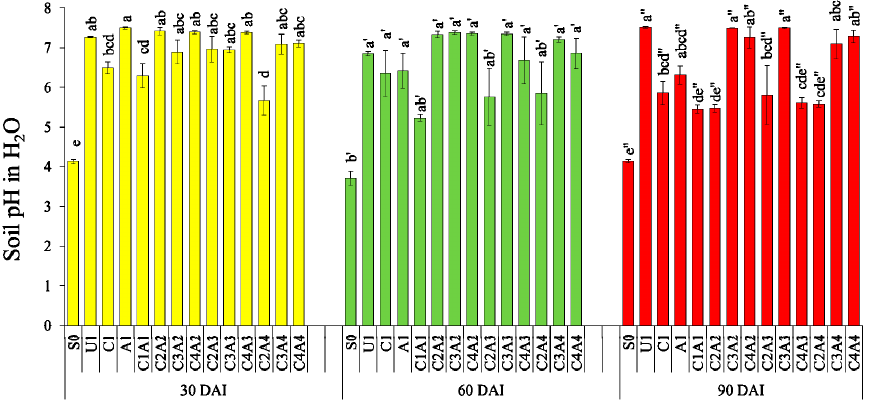
Figure 2. Treatments on soil pH in water after thirty, sixty, and ninety days of incubation. Means with different letter(s) within the same incubation period indicate significant difference between treatments by Tukey ’ s HSD test at p ≤ 0.05. Bars represent the mean values ± SE.